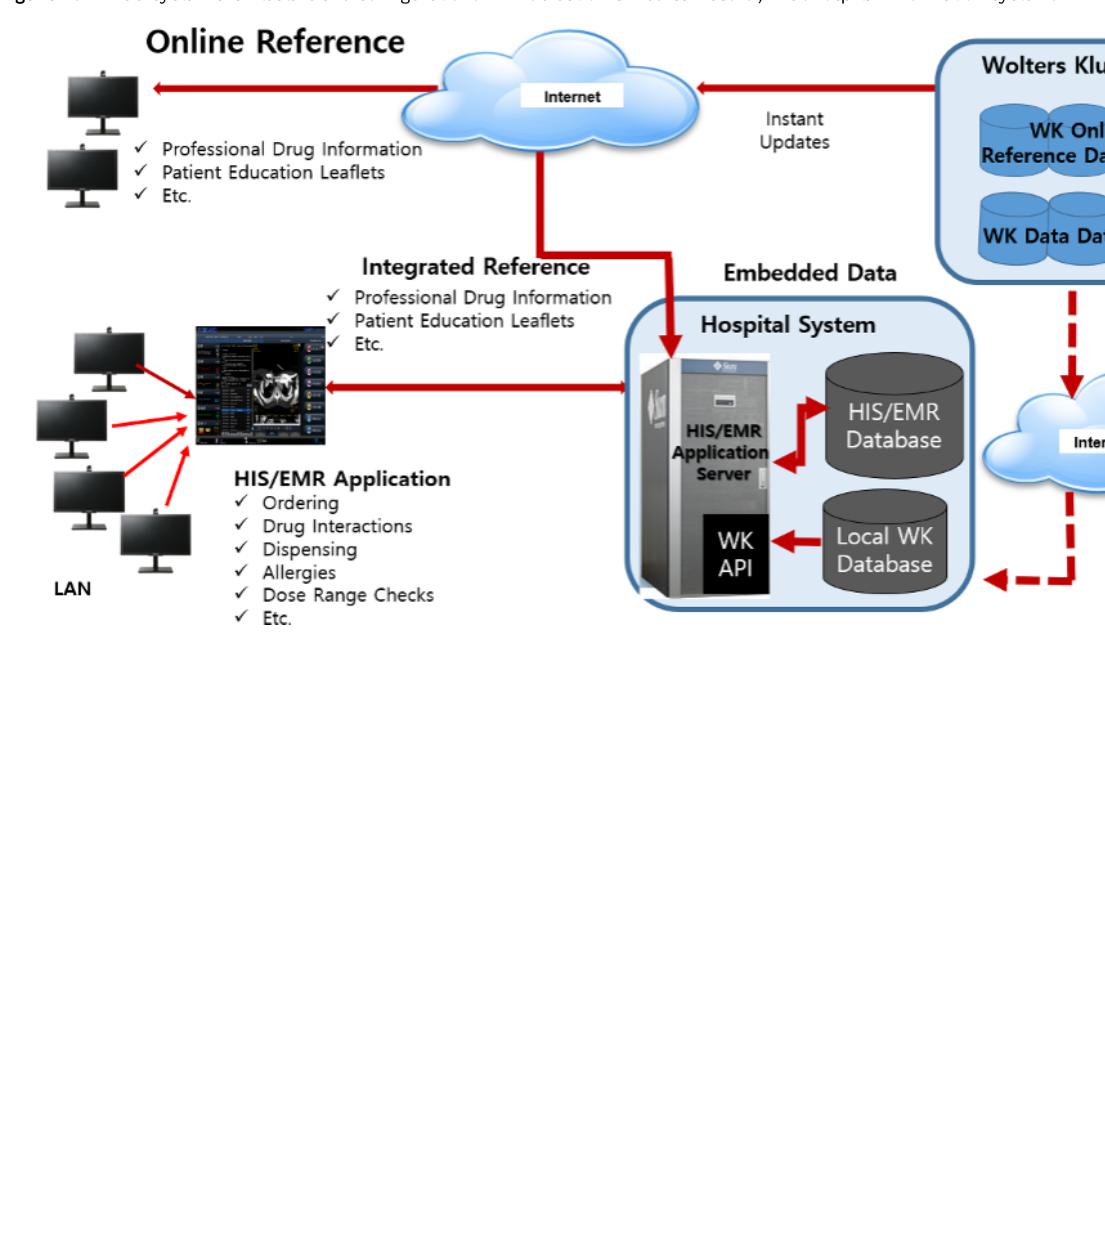
Figure 1. MDSS system architecture and configuration. EMR: electronic medical record; HIS: hospital information